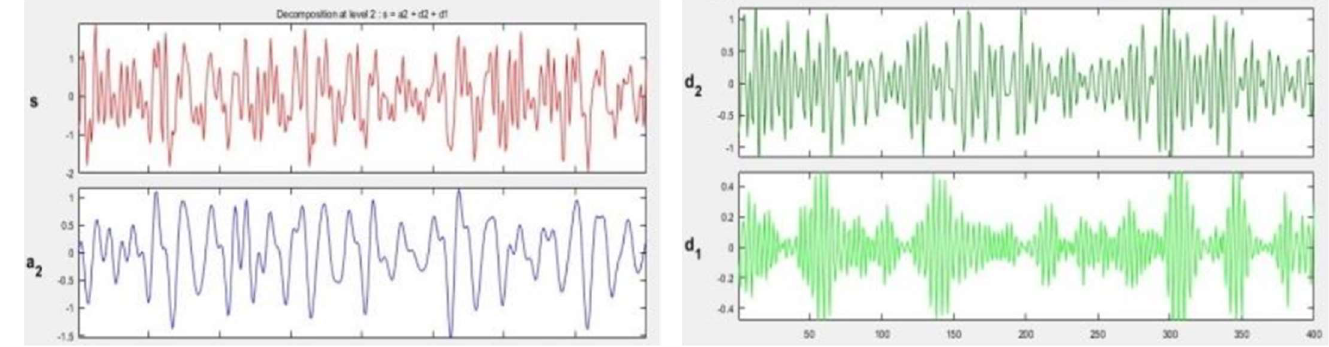
Figure 3. The output result of wavelet transform.